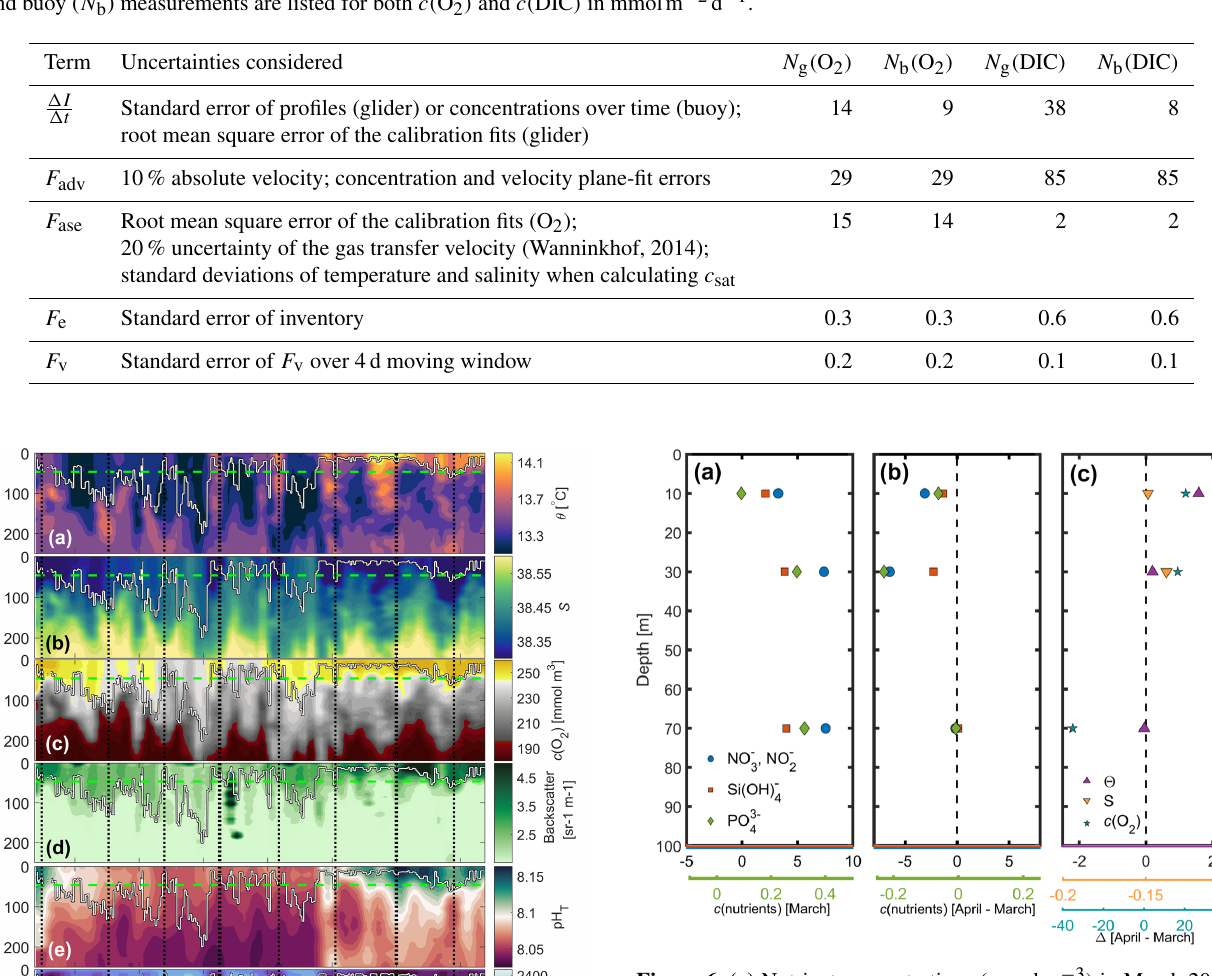
Figure 6. (a) Nutrient concentrations (mmolm − 3 ) in March 2016, (b) change in nutrient concentrations between March and April 2016, and (c) changes in potential temperature ( θ ), practical salinity ( S ) and c (O 2 ) (mmolm − 3 ) between March and April